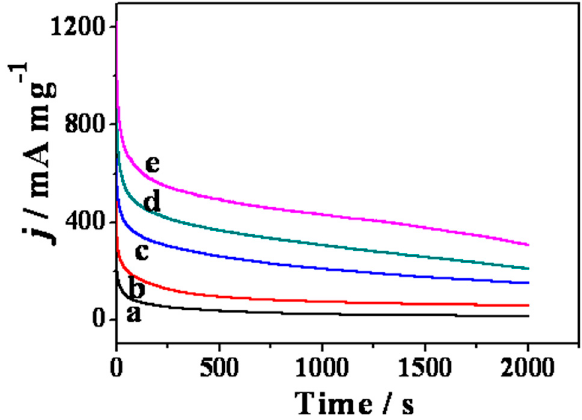
Figure 10. Chronoamperograms in 0.5 M H 2 SO 4 + 1.0 M CH 3 OH: Pt/C-JM (a), Pt/GNs (b), Pt-Ag/GNs (c), Pt-Ag/GNs under durative visible irradiation (d) and Pt-Ag/GNs under durative UV irradiation (e).